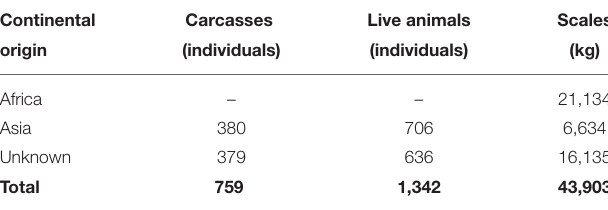
Bold values along bottom row are total number or quantity for each column. Value at bottom of column 2 and 3 is total number of individuals, and value at bottom of column 4 is total quantify of scales in